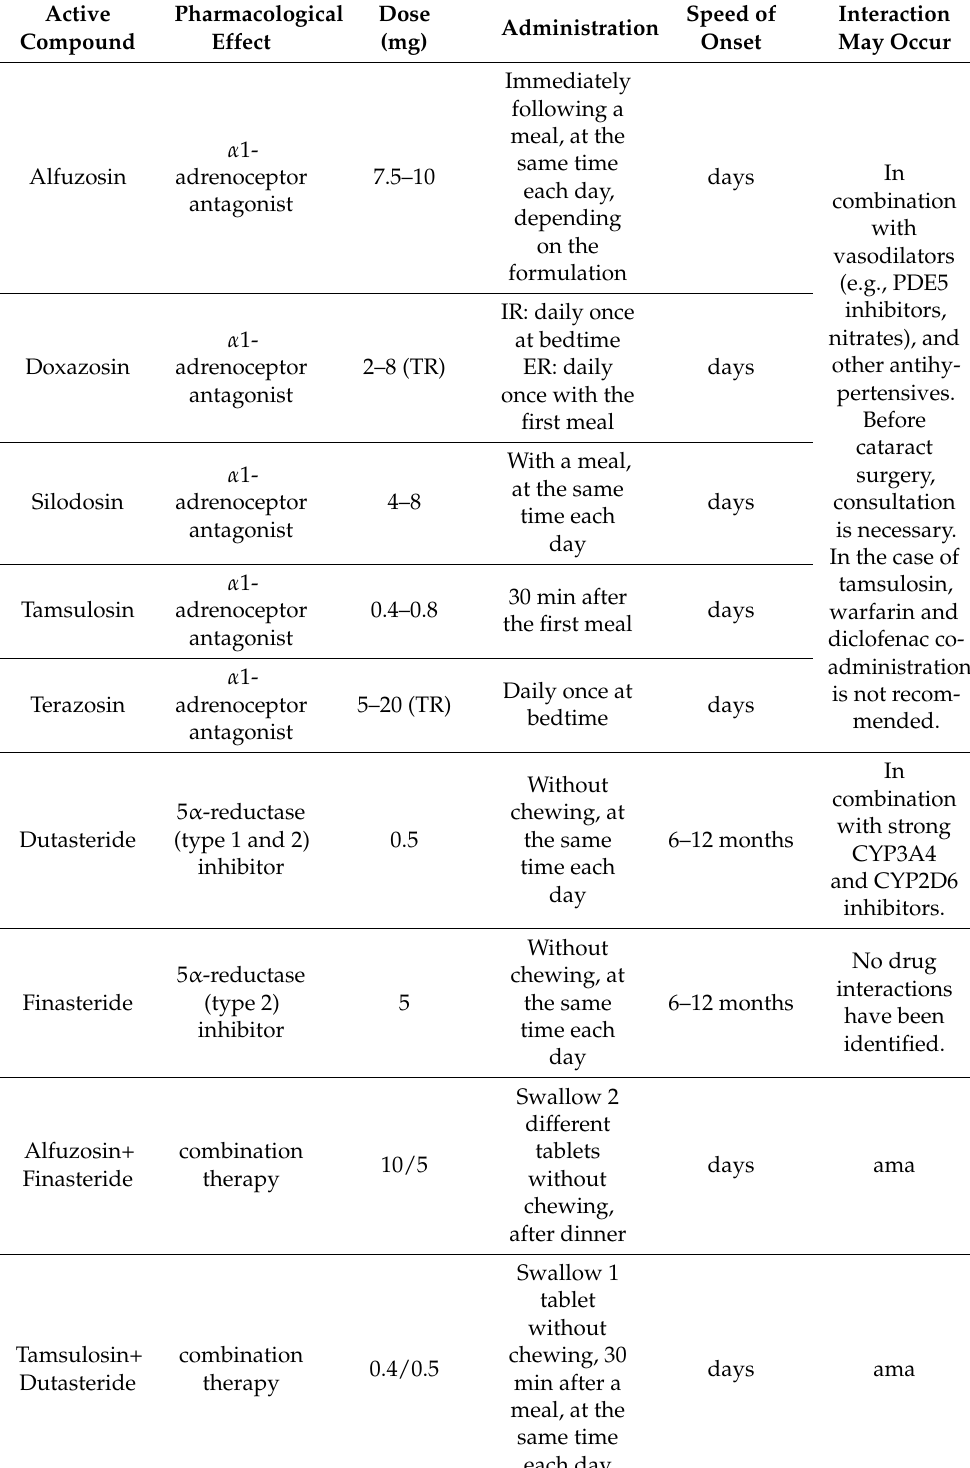
Table 1. Most frequently used active compounds licensed in Europe in the treatment of LUTS [10,11,15]. Active